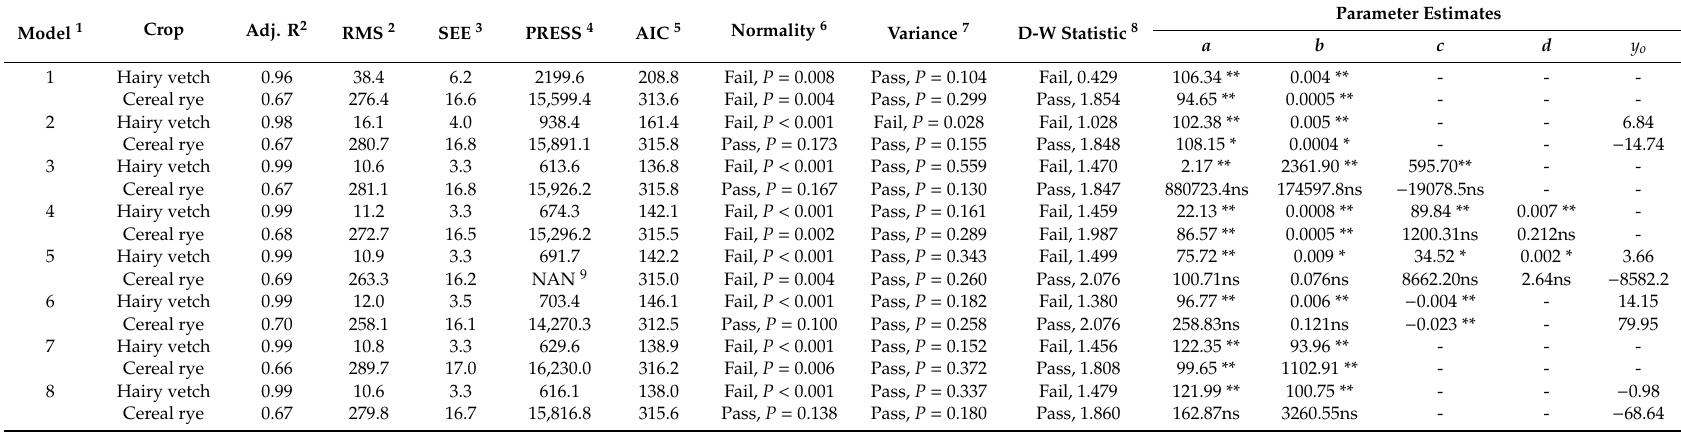
Table 5. Evaluation of models used to describe percent N remaining of aboveground biomass of hairy vetch and cereal rye cover crops at Exp. 1 in 2015. Data were from no-till plots at Carbondale,